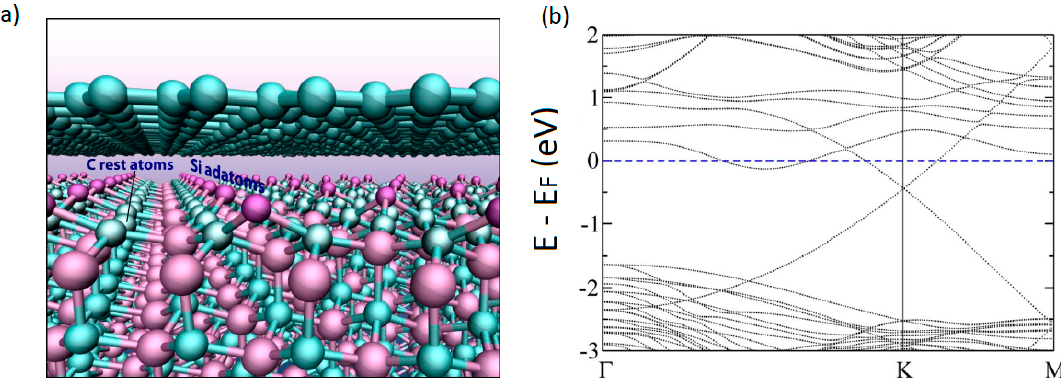
Figure 10. ( a ) EG / SiC(0001) interface with the (2 × 2) C surface reconstruction. Si adatoms and C rest atoms are marked. Adapted with permission from Reference [5]. Copyright (2012) AIP Publishing. ( b ) Electronic band structure of EG on SiC(0001 ). Adapted with permission from Reference [31]. Copyright (2007) American Physical Society.